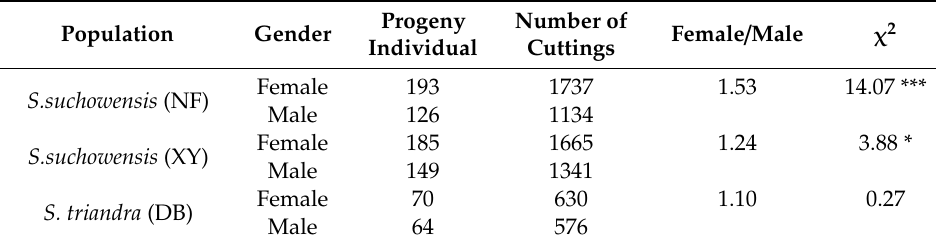
Table 1. The individual ratio of males and females in three willow populations. Population Gender